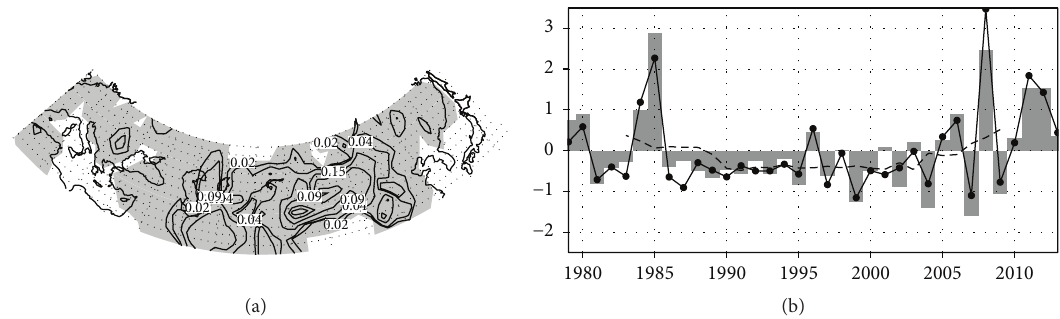
Figure 2: (a) EOF1 mode of the CI anomalies at 30–55 ∘ N in Eurasia. (b) Standardized time series of PC1 (dotted solid line), the regional (30– 55 ∘ N, 0–180 ∘ E) average CI (ECI, bar), and its corresponding 9-yr running mean (dashed line). The areas with positive values are shaded in